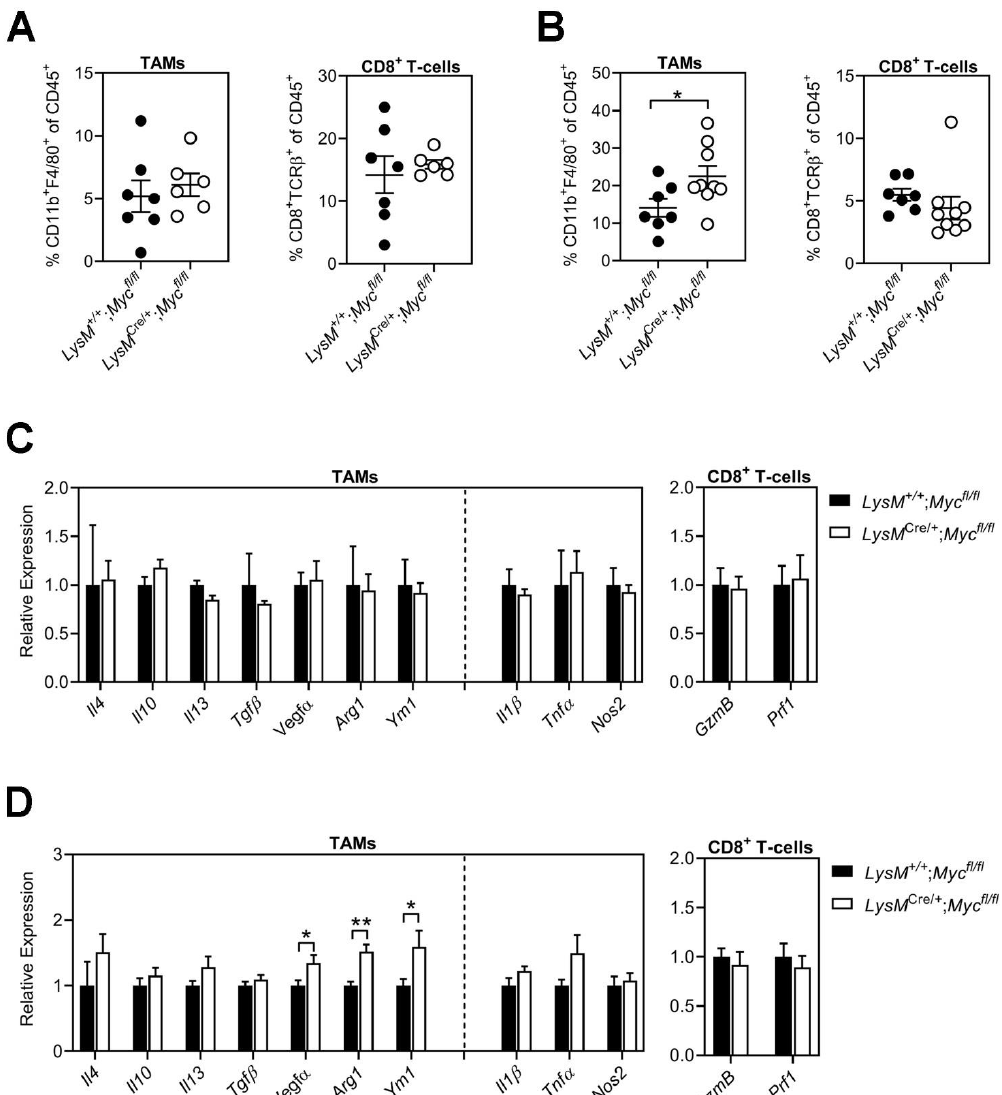
Figure 4. Genetic reduction of Myc in TAMs does not inhibit alternative macrophage polarization or stimulate adaptive anti-tumor immunity. ( A , B ) Quantification of TAMs and CD8 + T-cells in subcutaneous ( A ) B16F10 and ( B ) MC38 tumors of LysM +/+ ; Myc fl/fl and LysM Cre/+ ; Myc fl/fl hosts. Each symbol represents an individual mouse. n ≥ 6 mice per group. ( C , D ) qPCR analysis on CD45 + CD11b + F4/80 + Ly6C - LygG - TAMs and CD45 + TCRβ + CD8 + T-cells isolated from subcutaneous ( C ) B16F10 and ( D ) MC38 tumors of LysM +/+ ; Myc fl/fl and LysM Cre/+ ; Myc fl/fl hosts. n ≥ 3 mice per group. Data represent mean ± SEM; * p < 0.05, ** p < 0.01, with statistical significance determined by an unpaired Student’s t -test.